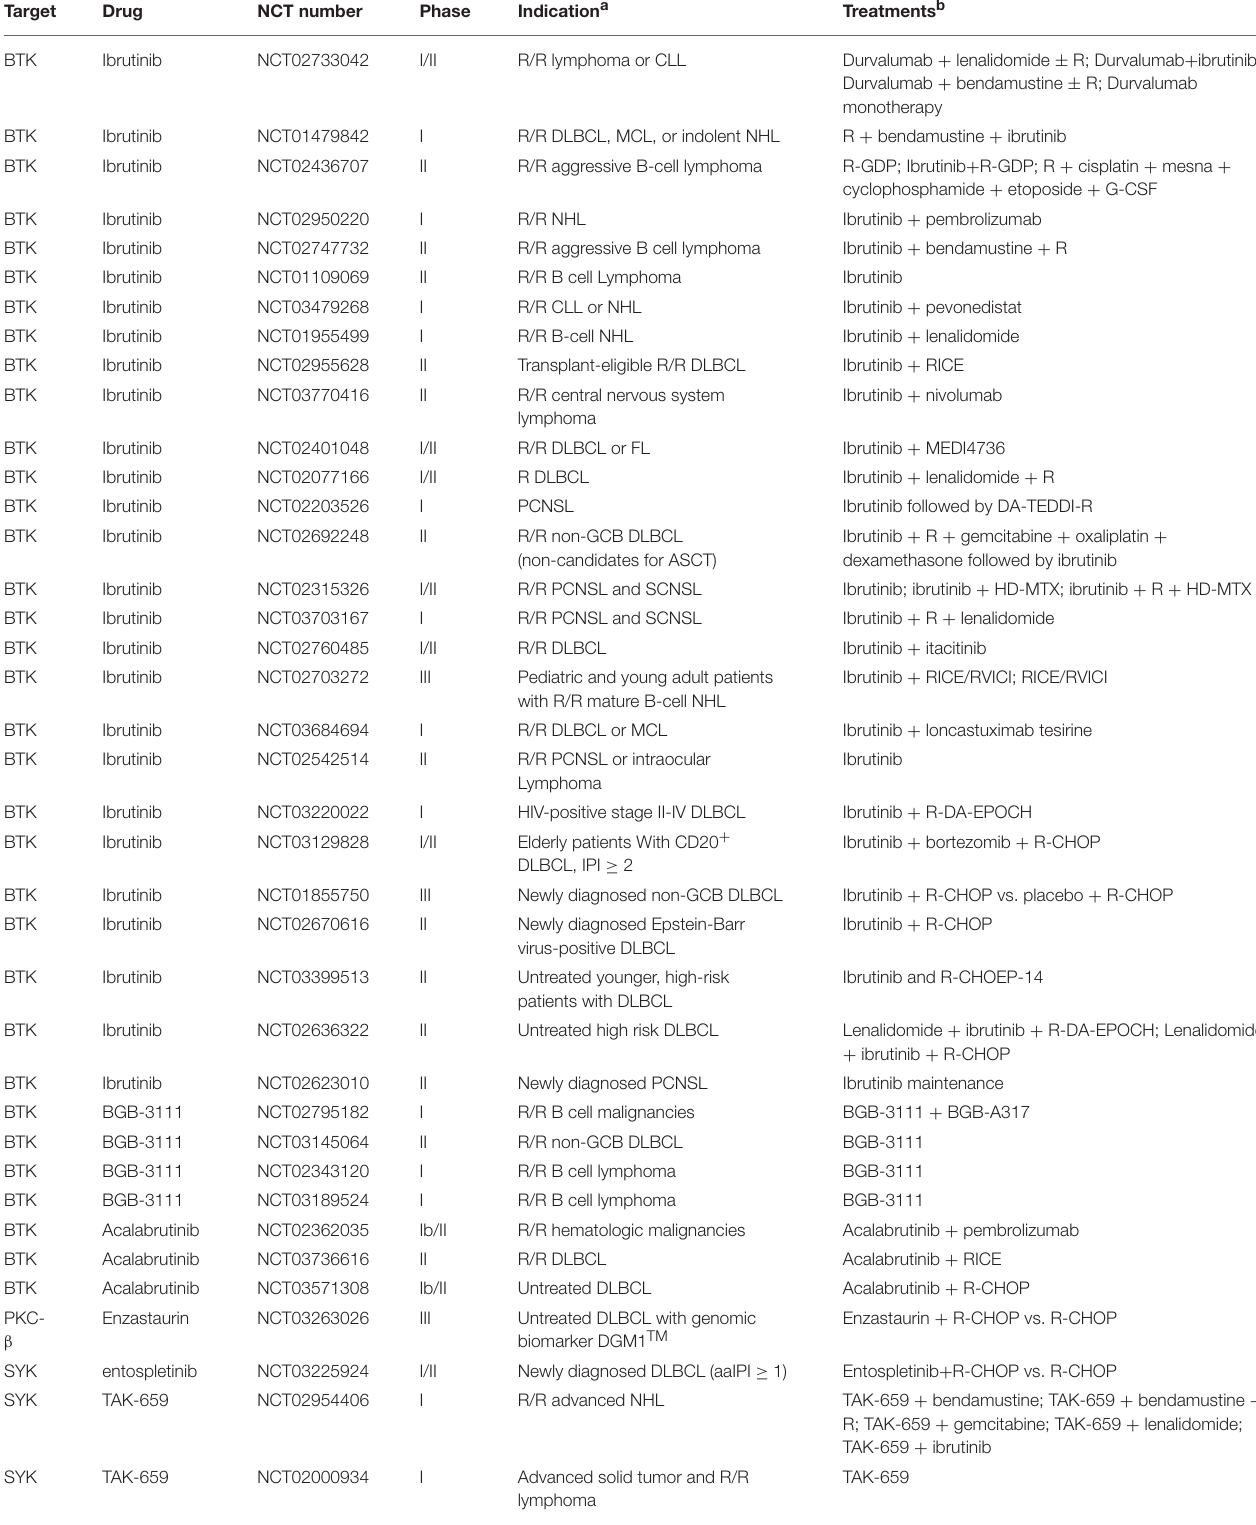
TABLE 2 | Ongoing trials with drugs targeting cell survival in diffuse large B cell